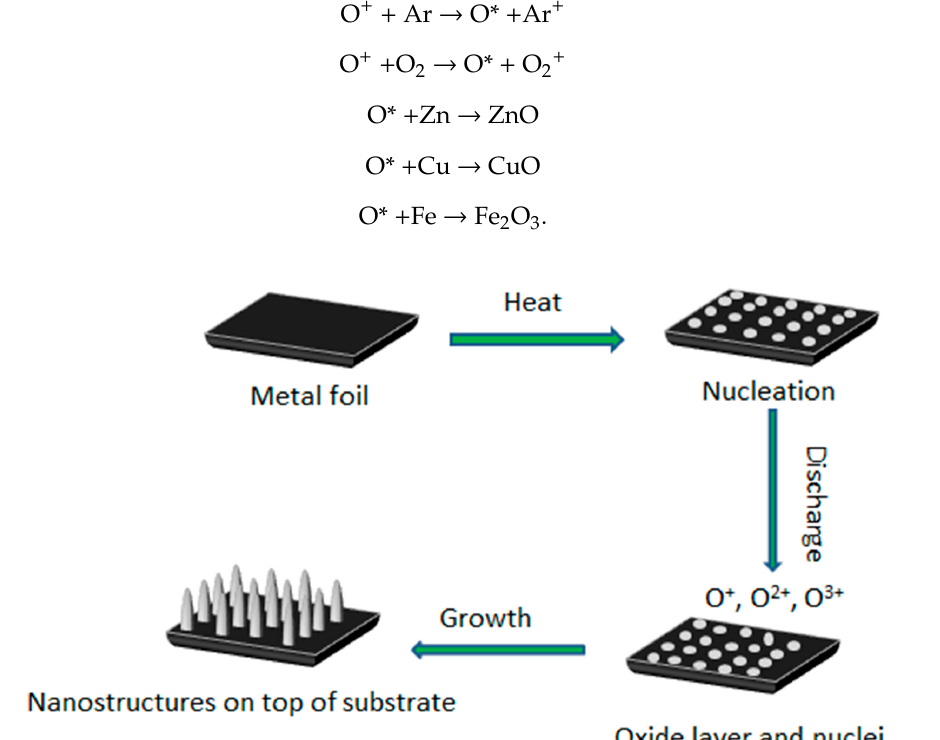
Figure 7. Schematic illustration of the initial stages of the growth process for the metal oxide nanostructures produced under plasma. These stages lead to the nucleation, nanowire growth, and formation of a thin oxide layer.